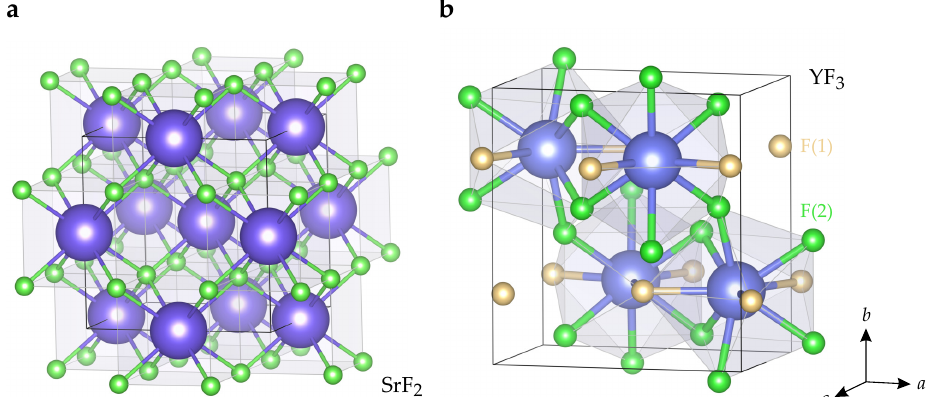
Figure 1. ( a ) Crystal structure ( Fd ¯3 m ) of cubic SrF 2 with the Sr 2 + ions (spheres in light blue, ionic radius 0.99 Å) occupying the 4 b positions coordinated by eight fluorine anions residing on 8 c ; In ( b ) the crystal structure orthorhombic of YF 3 ( Pnma ) is shown; the trivalent Y 3 + ions (light blue spheres, ionic radius 0.90 Å) occupy the 4 c sites, two further crystallographically inequivalent F sites exist which are filled by the F anions F(1) and F